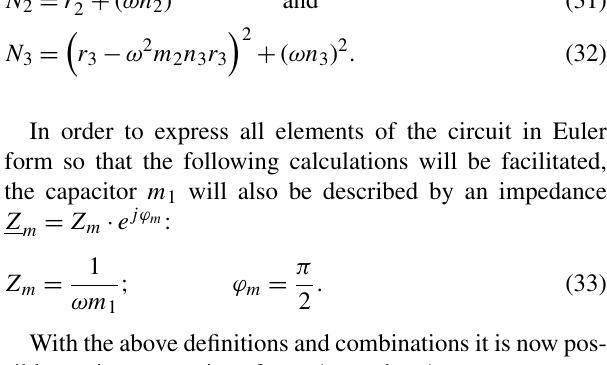
Figure 13. Amplitude curves for both cantilevers for the circuit model in Fig. 12 with and without an external interaction, repre- sented by the spring k 3 and d 3 =